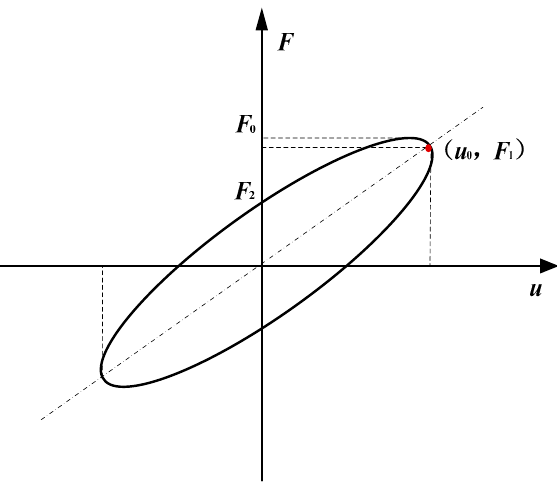
Figure 1. Force-displacement hysteresis curve. Figure 1. Force ‐ displacement hysteresis curve.